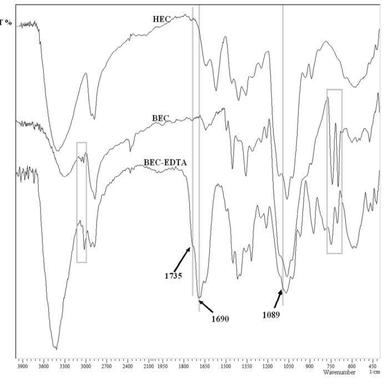
FTIR Spectra of HEC, BEC and BEC-EDTA